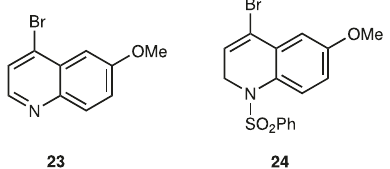
Fig. 7 | Bromoquinoline derivatives. Bromoquinoline derivatives were investi- gated by Ishikawa ’ s